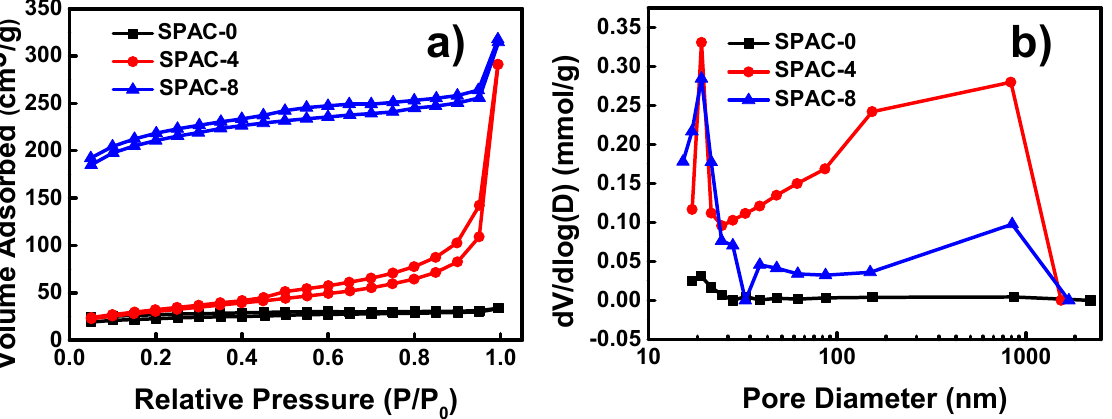
Figure 2. N 2 adsorption-desorption isotherms ( a ) and pore size distributions ( b ) of SPAC-0, SPAC-4 and SPAC-8.